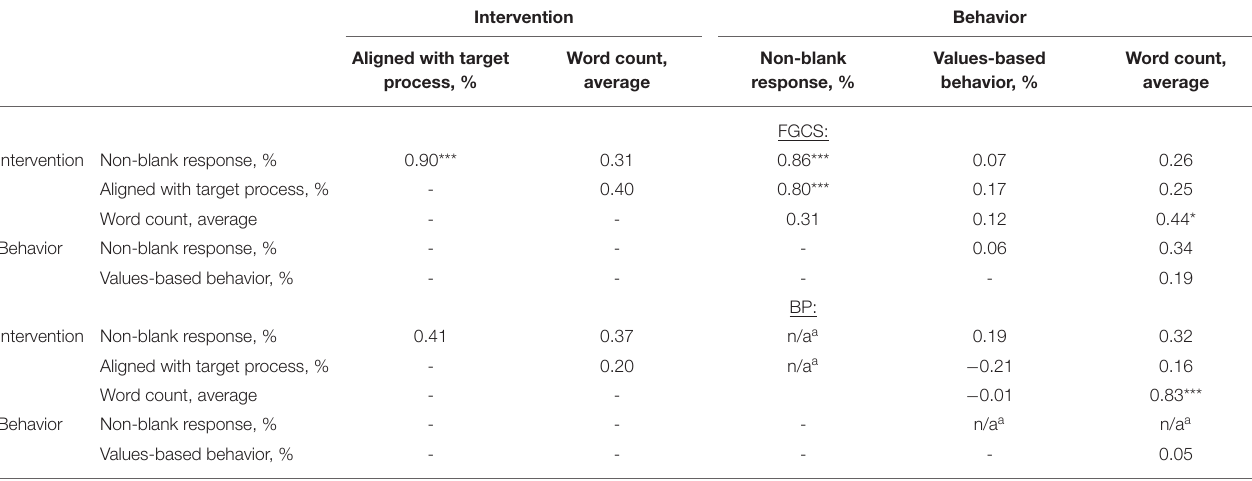
TABLE 2 | Correlation between metrics of engagement with ACT processes.